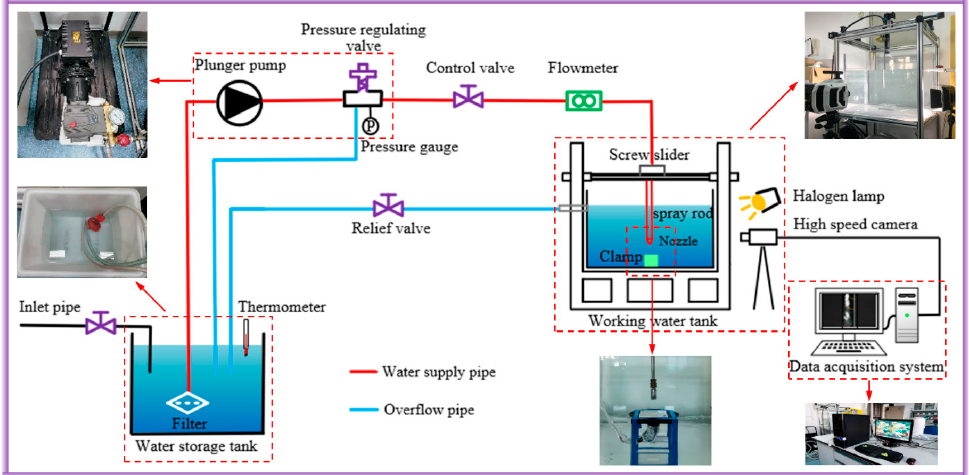
Figure 1. Schematic diagram of experimental setup for the submerged cavitation jet.